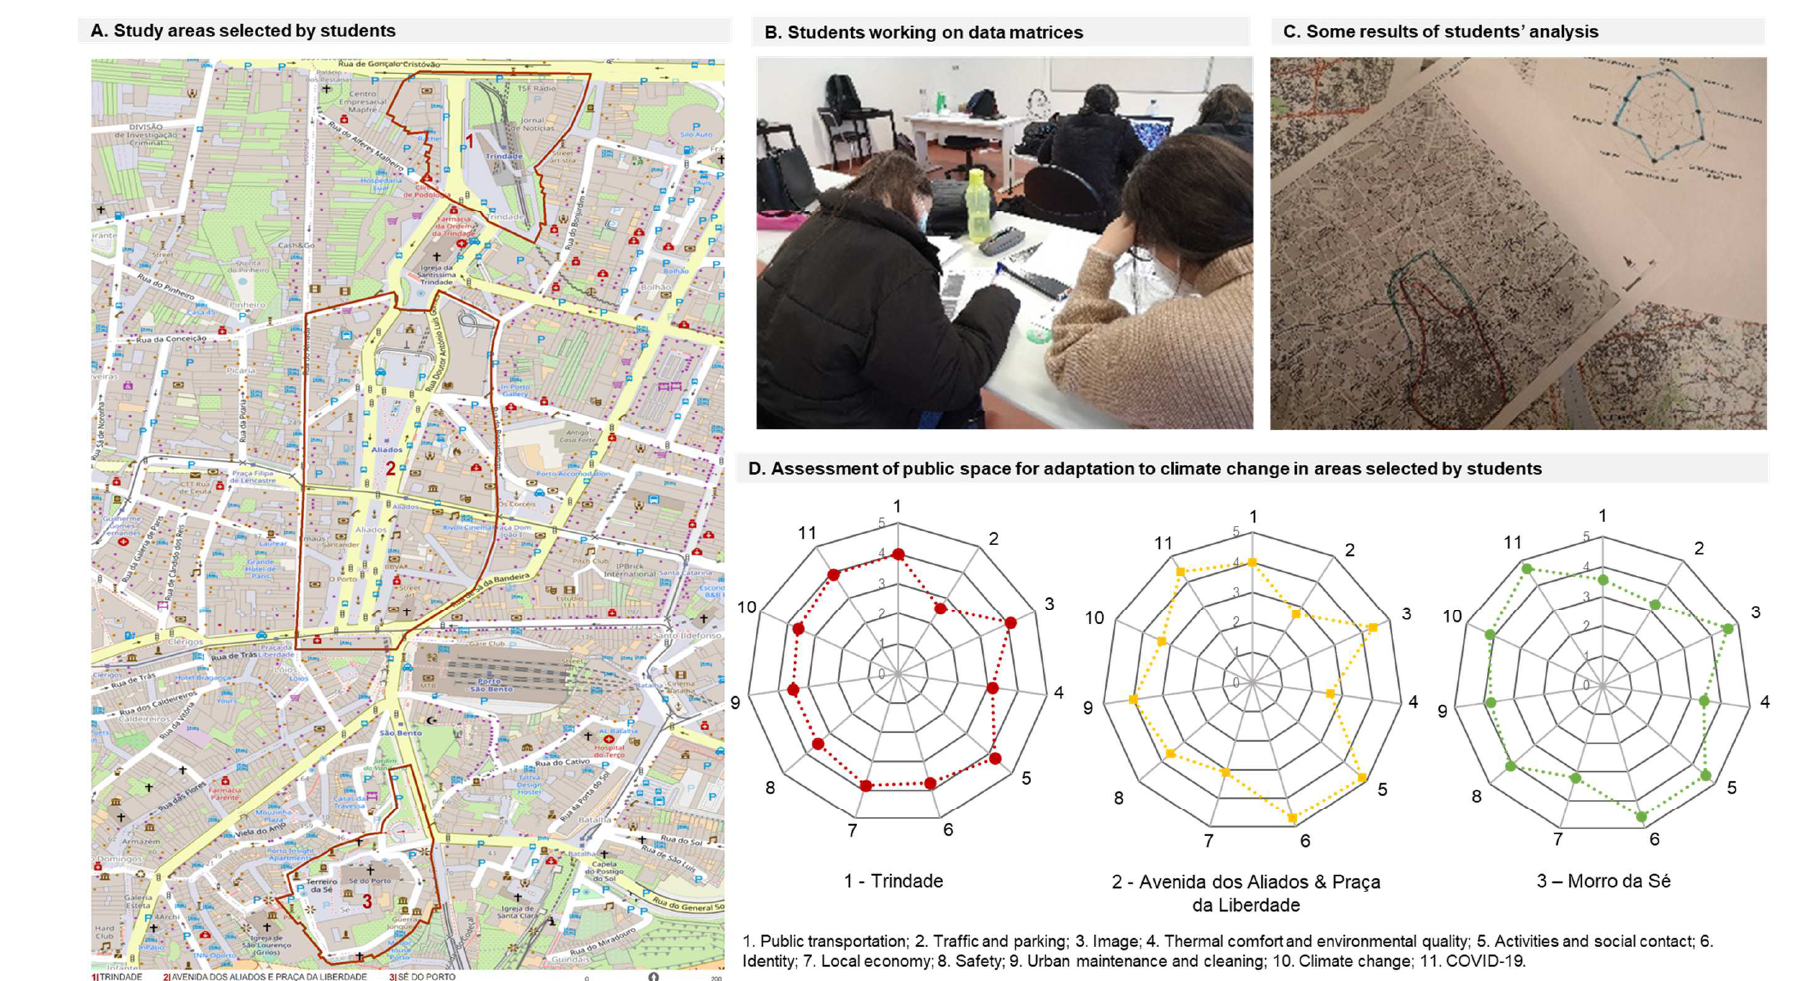
Figure 3. Evaluation of public space in the Porto Metropolitan Area—diagnostic phase (Territory). ( A ) Study areas selected by students; ( B ) Students working on data matrices; ( C ) Some results of student analysis; ( D ) Assessment of public space for adaptation to climate change in areas selected by students. Source: Authors’ own elaboration. Photos were taken by the authors on 8 December 2021 ( B ) and 5 January 2021 ( C ).